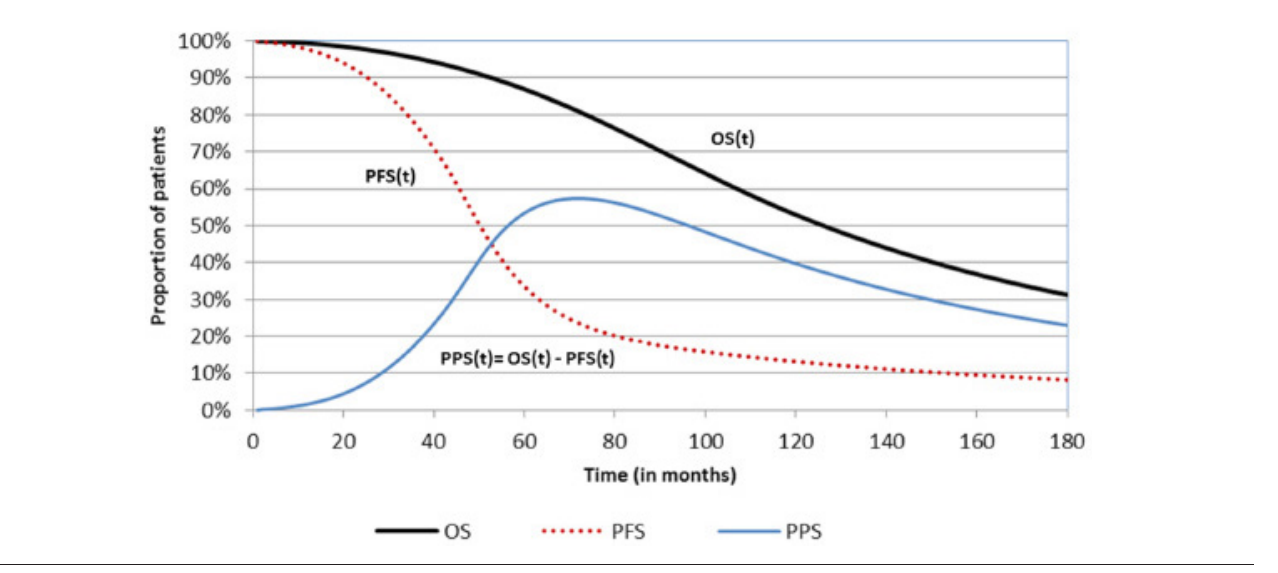
PFS: progression-free survival; PPS: post-progression survival; OS: overall